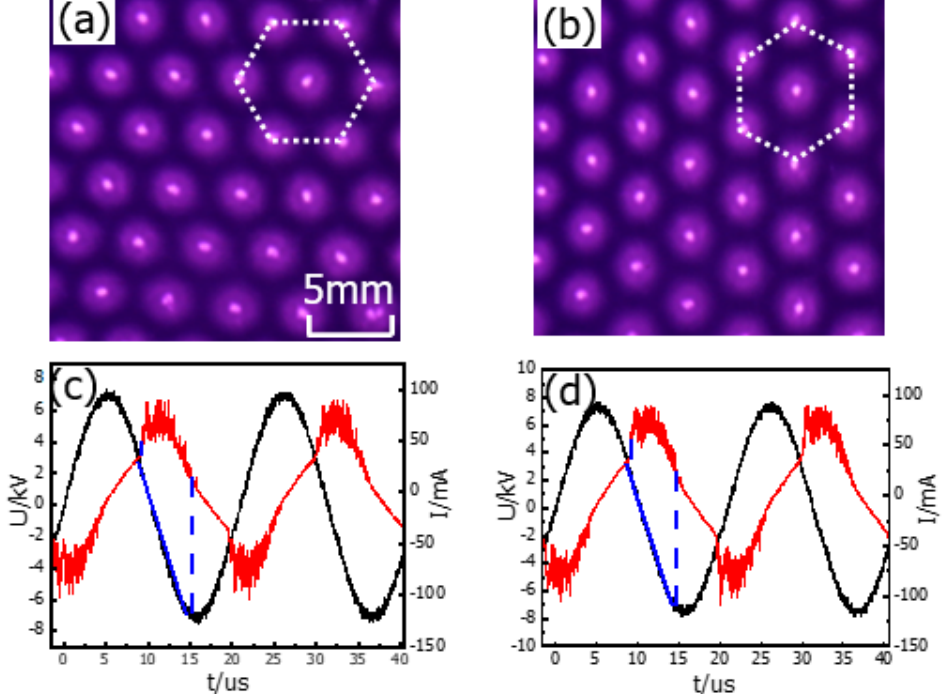
Figure 6. Reorientation of the triangular lattices when increasing of the applied voltage. ( a , b ): snapshots of the plasma structures. ( a ) U = 7.4 kV, p = 52 W ( b ) U = 7.6 kV, p = 56 W. The other discharge parameters are: f = 53 kHz, p = 440 torr, d = 2.0 mm, t = 40 ms. The working gas is 65% Ar and 35% air. The white dotted hexagons indicate the angular reorientation of the plasma photonic crystals. ( c , d ): the corresponding voltage-current waveforms associate with the triangular lattices of different orientations. The blue lines on the voltage waveforms indicate the ranges of the voltages that the discharges occur.